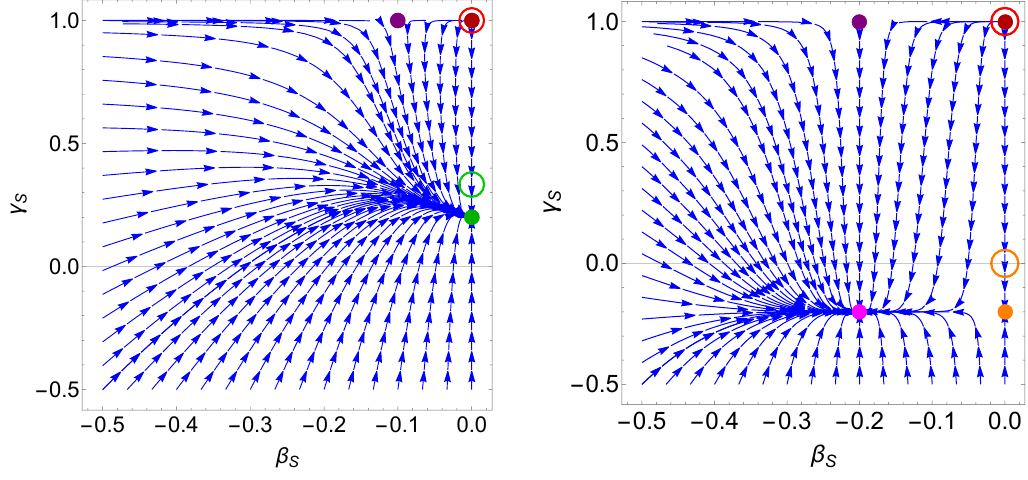
Figure 5 . Stream flow of the scaling exponents. Blue arrows represent the flow of the scaling exponents β S , γ S under time evolution. (left) f (cid:29) 1 , (right) f (cid:28) 1 . For illustrative purposes, we set ˙ l Cb = 0 . 4 and show the corresponding fixed points in filled circles. Fixed points of the evolution equations with ˙ l Cb = 0 are shown as open circles. Red and purple markers show the free-streaming fixed point with the “anomalous” correction and the one without the “anomalous” correction, respectively. Green markers show the BMSS fixed point. The orange and pink markers show the dilute fixed point with the anomalous correction in both β S and γ S and the one with only the “anomalous” correction in γ S ,